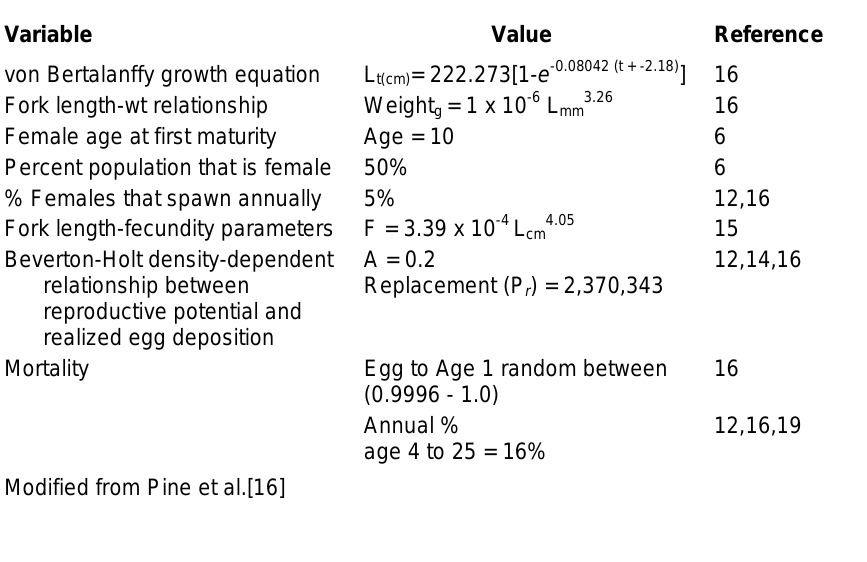
Population Attributes Held Constant or within Set Ranges in MOCPOP Simulation